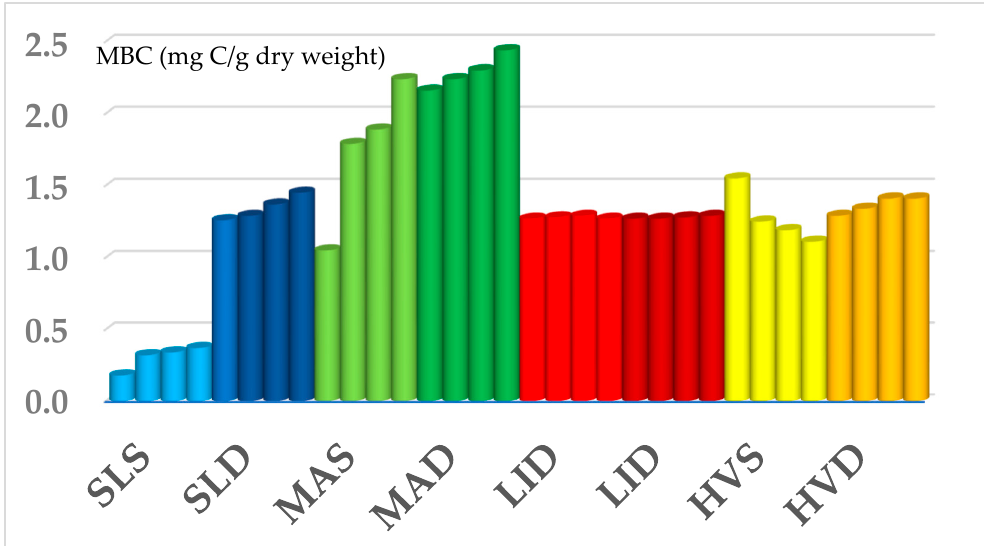
Figure 7. Evolution of microbial biomass carbon (MBC) values (mg C/g) during four sampling seasons on each monitored locality–every color represents a sample: SLS (light blue), SLD (dark blue), MAS (light green), MAD (dark green), LIS (light red), LID (dark red), HVS (yellow), HVD (orange); the average values are shown in the figure for every season, the standard deviation of the means of seasons I–IV were as follows: SLS ± 0.07; 0.08; 0.06; 0.03, SLD ± 0.08; 0.04; 0.13; 0.14, MAS ± 0.04; 0.85; 0.14; 0.07, MAD ± 0.14; 0.13; 0.22; 0.08; LIS ± 0.11; 0.17; 0.11; 0.18, LID ± 0.16; 0.22; 0.12; 0.11, HVS ± 0.33; 0.19; 0.28; 0.18, HVD < 0.01; ± 0.04; 0.06;